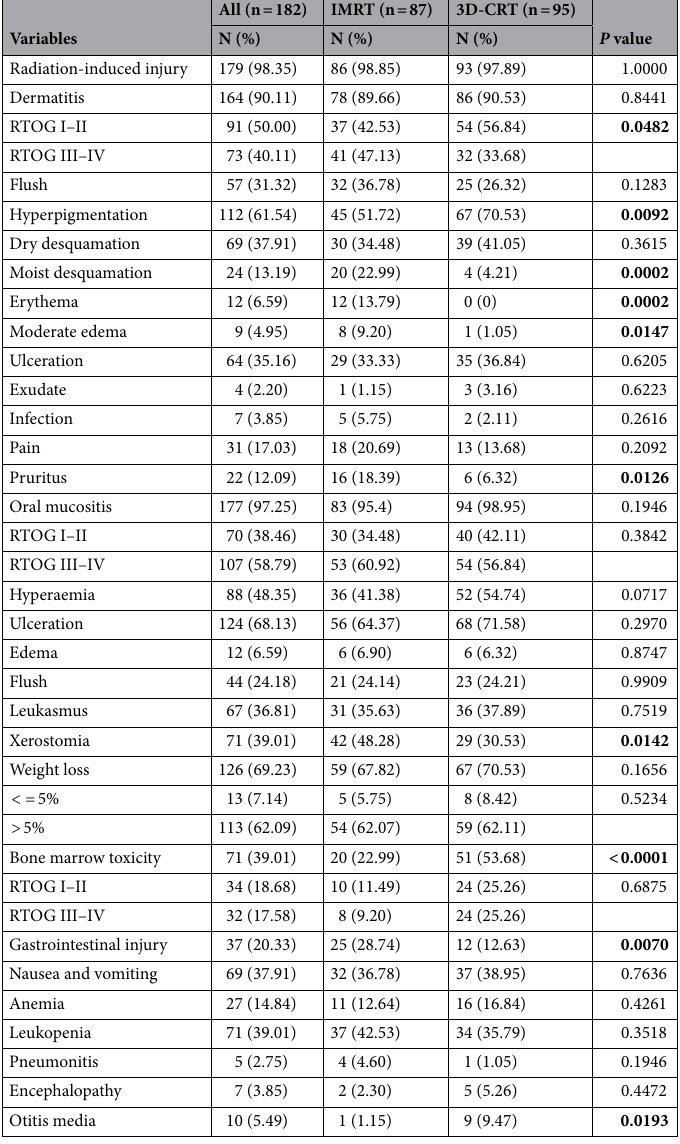
Table 2. Incidence of radiation-injuries by radiotherapy modality. IMRT intensity modulated radiation therapy, 3D-CRT three-dimensional conventional radiotherapy, RTOG Radiation Therapy Oncology Group. P values were calculated with Chi-square ( χ 2) test or Fisher’s exact test. The use of bold formatting means P <